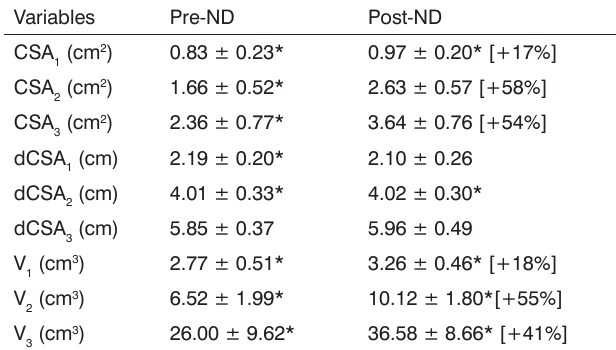
, Table 2. Cross-sectional areas (CSA 1 , dCSA , dCSA ), from the nostrils (dCSA 1 2 3 of adults with nasal obstruction before (Pre-ND) and after (Post-ND) the administration of